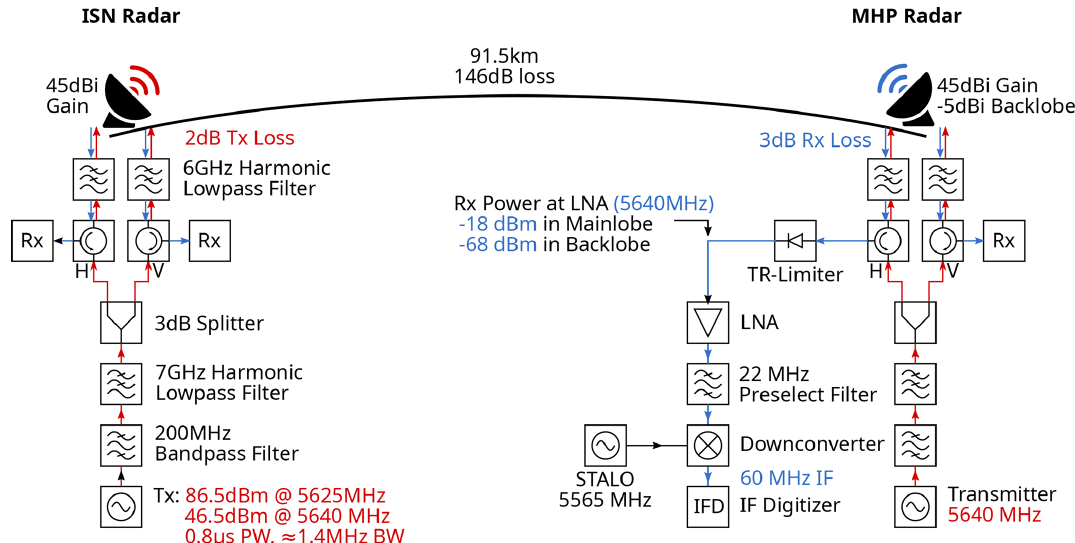
Figure 11. Radar setup used for the analysis. The transmit signal from the ISN radar at 5640MHz interferes with the Rx at the MHP radar at 5625MHz. Important radio frequency components are included for